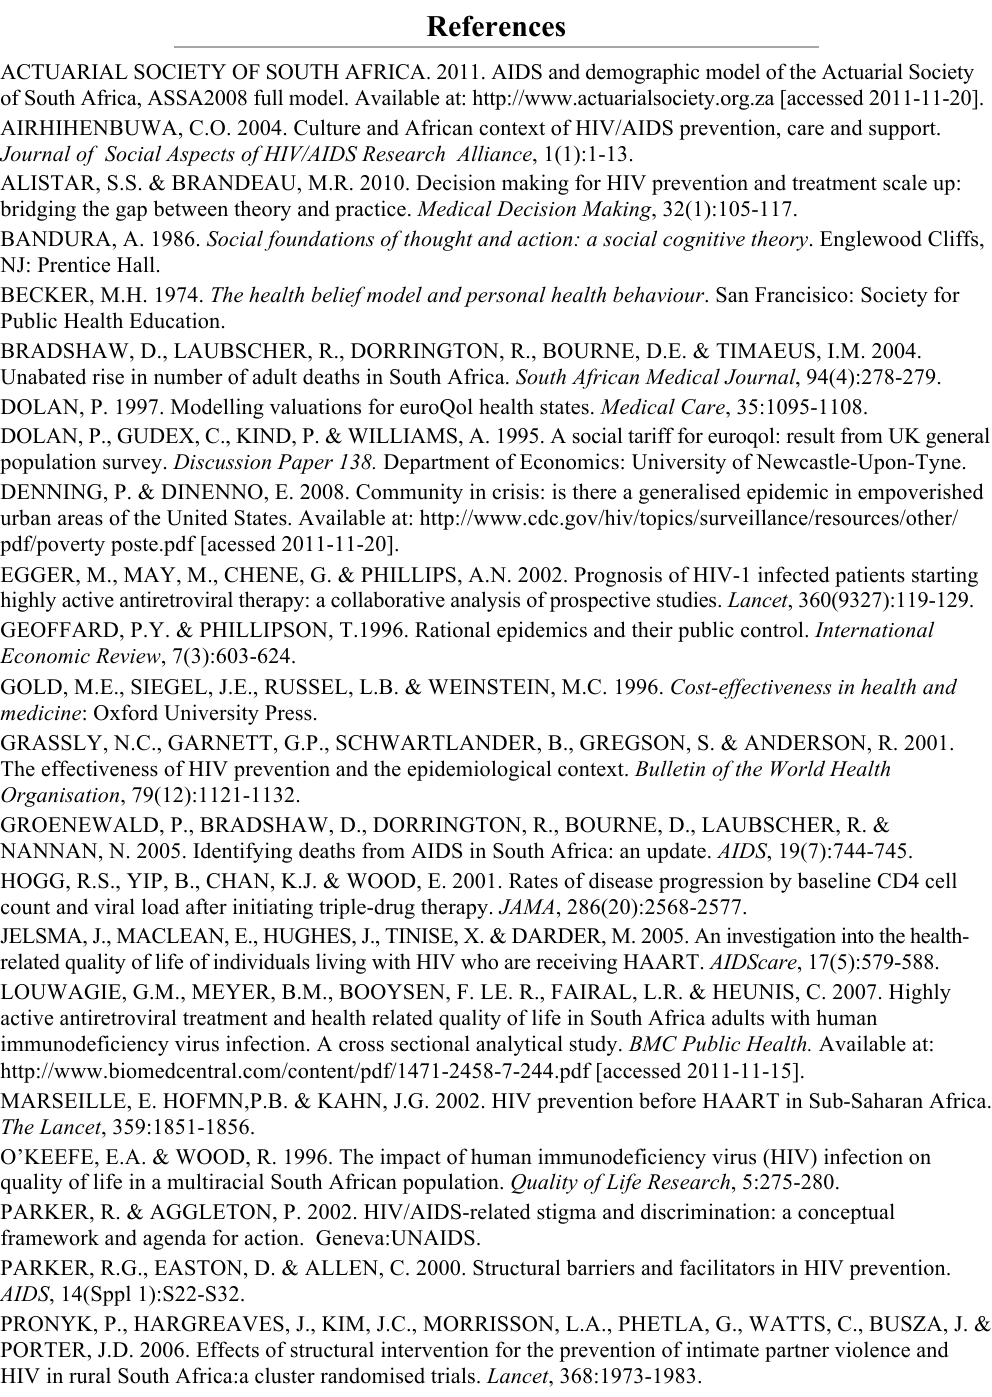
The analysis focuses only on the before -2010 guidelines for HAART and PMTCT because data for the 2010 guidelines for these two interventions are not available. In this paper the analysis of 2010 guidelines is based on